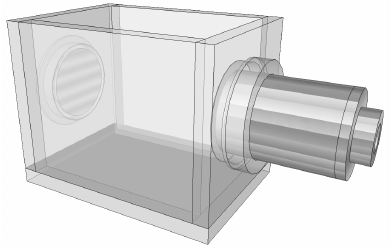
Figure 3. Illustration of the acoustic chamber prototype.